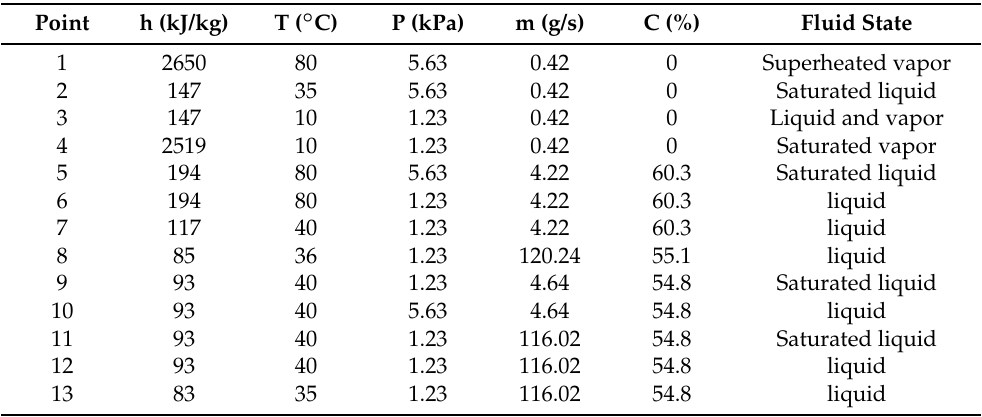
Table 1. The optimal design parameters of the LiBr/water absorption refrigeration system equipped with an adiabatic